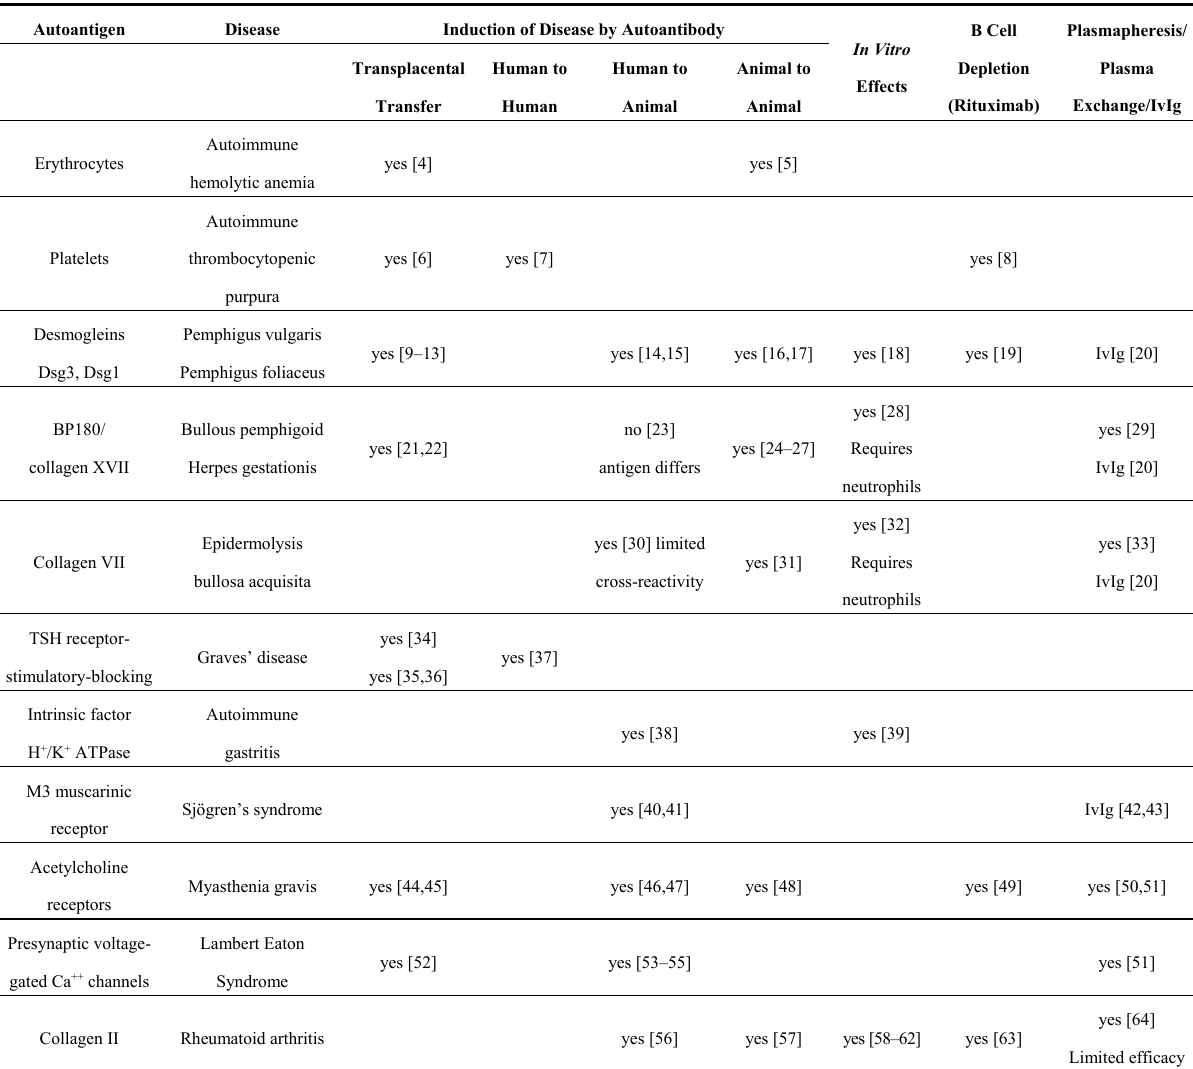
Table 1. Examples of pathogenic